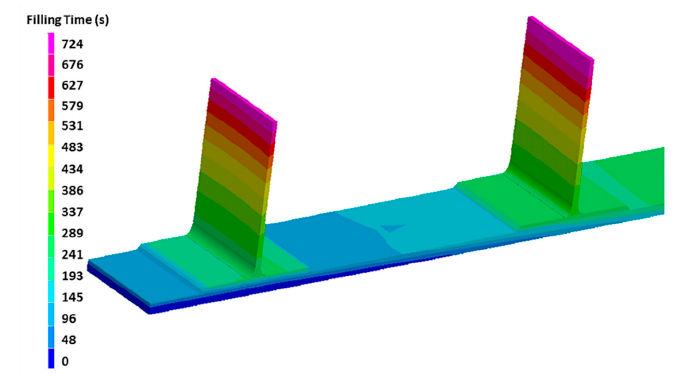
Figure 12. Filling time of the carbon fiber panel stiffened by stringers (half component is shown for clarity). for